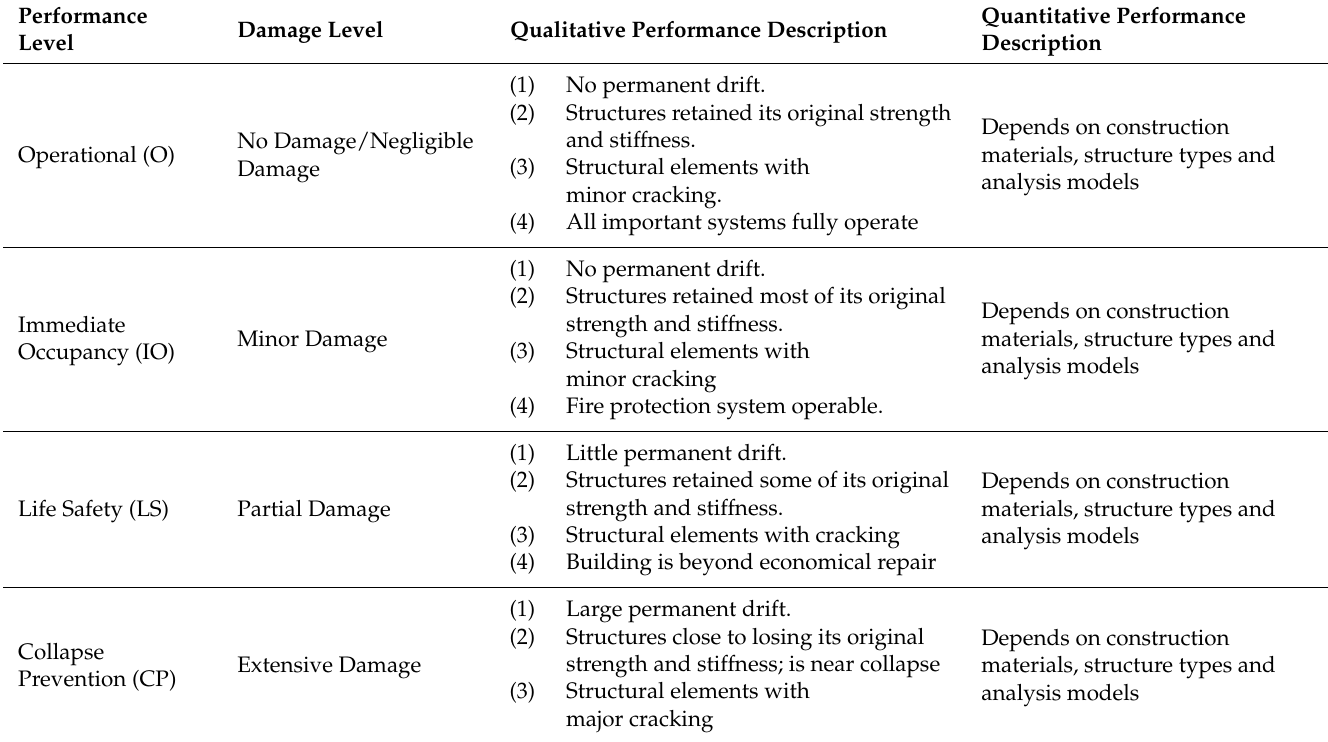
Table 1. Qualitative/quantitative seismic performance level [26]. Reproduced with permission